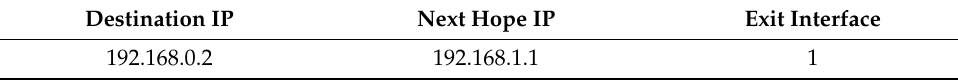
Table 1. Traffic